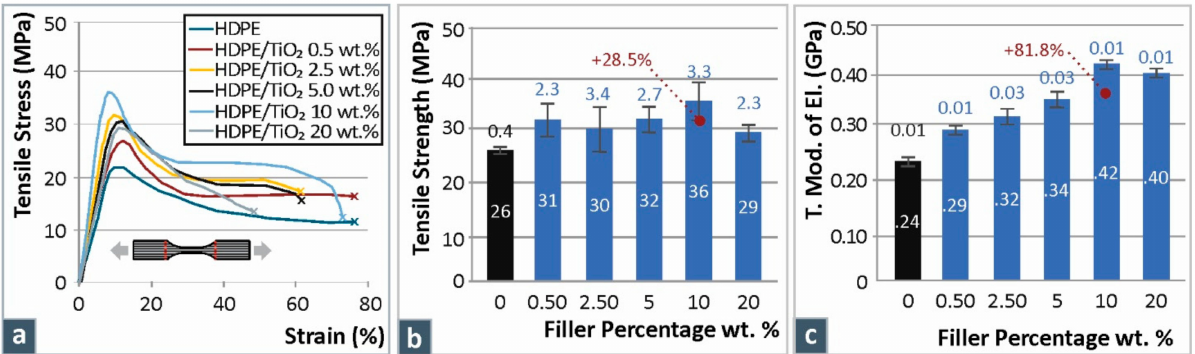
Figure 2. Overall ( a ) tensile stress vs. strain graphs for HDPE/TiO 2 , ( b ) comparative tensile strength graph, and ( c ) tensile mod. of elasticity for all the materials